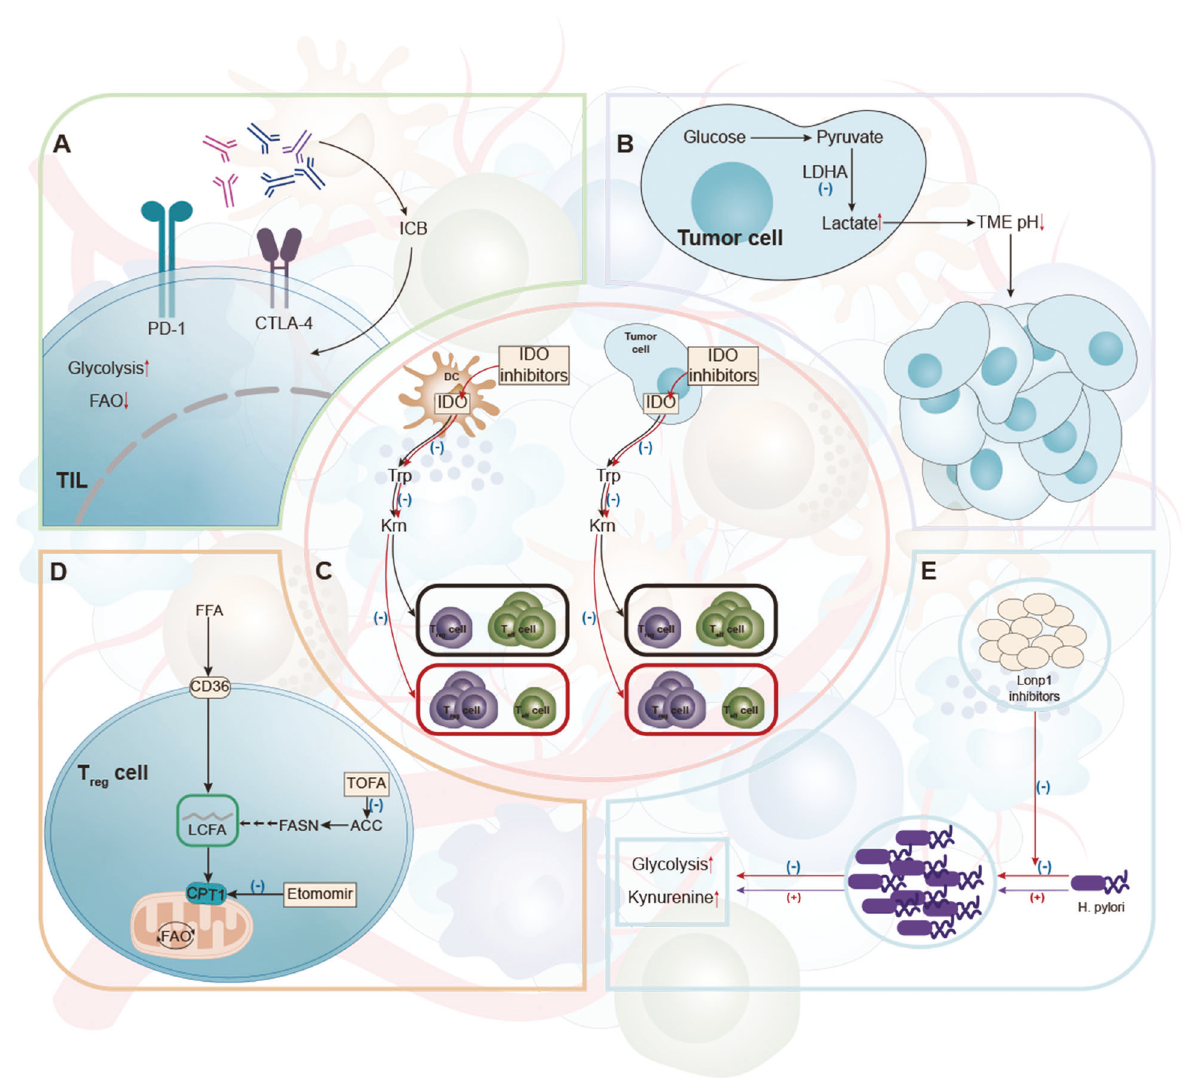
Fig. 3 Therapies that targeting immune metabolism. A Increased checkpoint receptor expression is usually a result of low glucose, acidity, or lactic acid in the TME, and the involvement of these receptors leads to immunosuppressive phenotypic characteristics of reduced glycolysis and increased FAO. Antibodies against these checkpoint receptors have successfully restored glycolysis, which in turn supports the function of antitumor effectors within immune cells. B LDHA is required for the conversion of pyruvate to lactic acid and is associated with the development, maintenance, and metastasis of cancer. LDHA is a potential therapeutic target. C Inhibitory immune cells, including Treg, TADCs and MDSC, increased the expression of IDO, an enzyme responsible for metabolizing tryptophan into canine urine. IDO-targeting activity inhibits these suppressive immune cells in the tumor. D Immunosuppressive Treg cells often use FAO as a way to produce energy. The metabolism of Treg can be improved by using ACC inhibitors, CPT1 inhibitors or CD36 inhibitors, providing potential targets for the treatment of gastric cancer. E In the TME of speci fi c gastric cancer, the micro fl ora was changed. In gastric cancer patients, a large increase of H. pylori led to an increase in tumor cell glycolysis and Lonp1. Downregulation of Lonp1 expression signi fi cantly reduced glycolytic metabolic transformation and gastric cell proliferation associated with low diversity of H. pylori using in a variety of cancer types. Immune checkpoint signaling can regulate metabolic activity. For example, the expression of programmed cell death 1 ligand 1 (PD-L1) in cancer cells can drive the activation of Akt-mTOR and glycolysis in cancer cells, increase glucose uptake, and enhance the ability to compete with T cells mutation load, microsatellites, ctDNA, GC molecular parting, etc. for glucose [143]. Increased checkpoint receptor expression is However, the correlation between these markers and immu- usually the result of low glucose, acid, or lactic acid in the TME. notherapy effect in advanced GC has not been fully demonstrated Immuno-checkpoints including PD-1, PD-L1 and CTLA-4, function and needs to be further explored. Beyond that microRNAs (miRs) to some extent by inhibiting glycolycolysis while increasing lipid are also take part in the development of GC. MiRs regulate gene solution and FAO. Although the use of checkpoint lockdown has expression by inhibiting mRNA translation or promoting its signi fi cantly improved the effectiveness of cancer treatment, it degradation. Samples of GC tissue were taken from patients with must be noted that current strategies are most effective against GC for miR-140 expression testing. MiR-140 expression highly glycolytic tumors (Fig. 3) [144, 145]. Research on GC